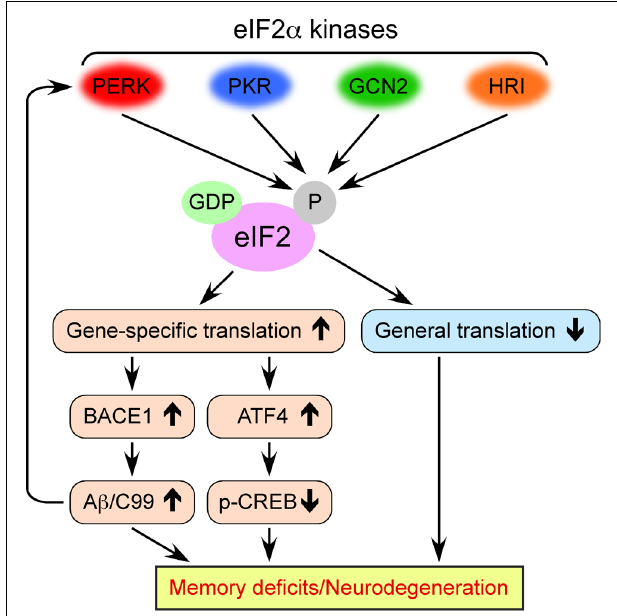
FIGURE 1 | Multiple molecular mechanisms by which dysregulated eIF2 α kinase activities may lead to memory deficits and neurodegeneration associated withAD. Four eIF2 α kinases become activated in response to diverse cellular stress stimuli. Persistent eIF2 α phosphorylation through aberrant activation of these kinases in AD causes the inhibition of general translation, while it activates gene-specific translation of mRNAs such as BACE1 and